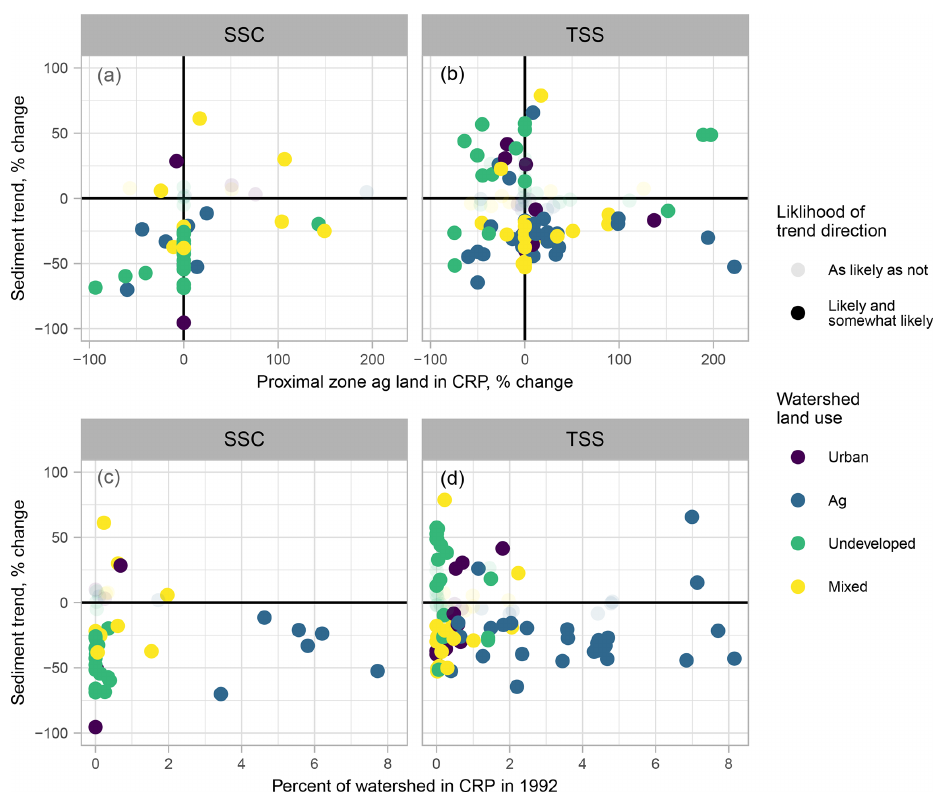
Figure 5. (a, b) Sediment trend versus percent change in proportion of agricultural land in the proximal zone enrolled in the Conservation Reserve Program (CRP) between 1992 and 2012. (c, d) Sediment trend versus percent of land in watershed enrolled in the CRP during the trend start year (1992). Note that all plots exclude site BRSS0035 (202% increase in TSS and 0% change in